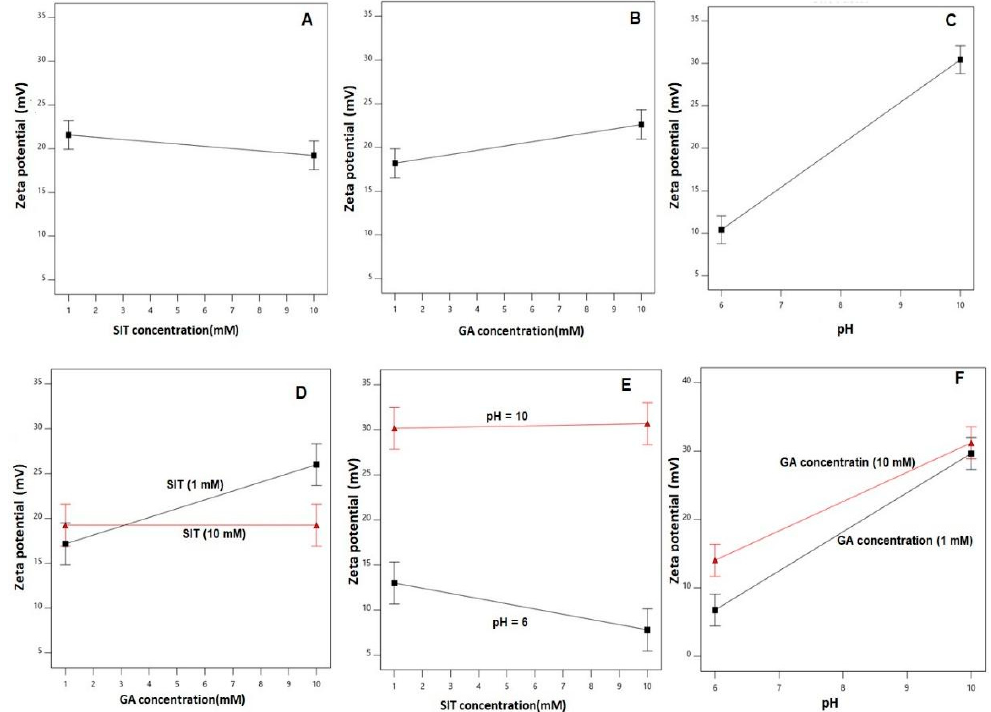
Figure 3. Main effects ( A to C ) and interactions ( D to F ) of the SIT concentration (X 1 ), GA concentration (X 2 ), and pH (X 3 ) on the zeta potential of the SIT-GA